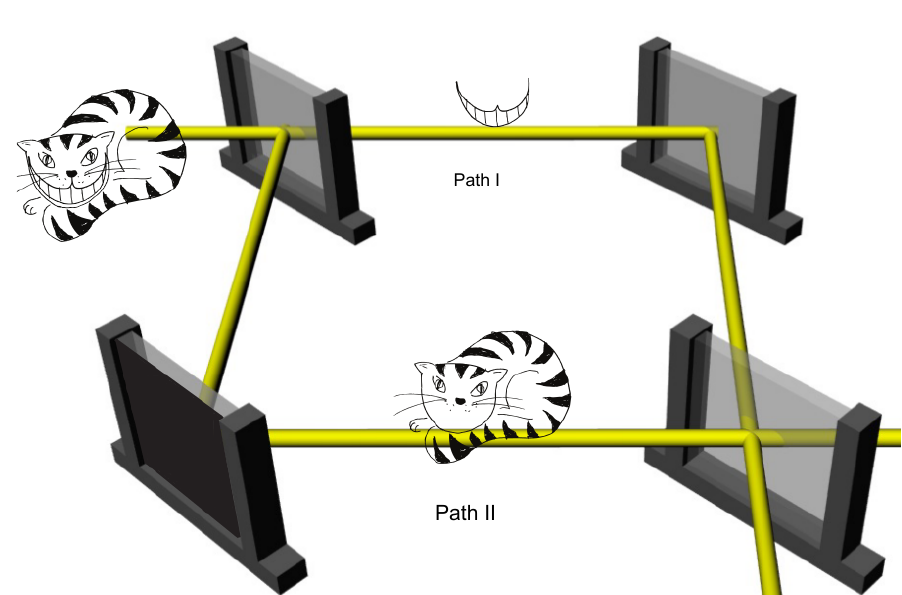
Figure 4. Artistic depiction of the quantum Cheshire Cat. Inside the interferometer, the Cat goes through the upper beam path, while its grin travels along the lower beam path. Figure courtesy of Leon